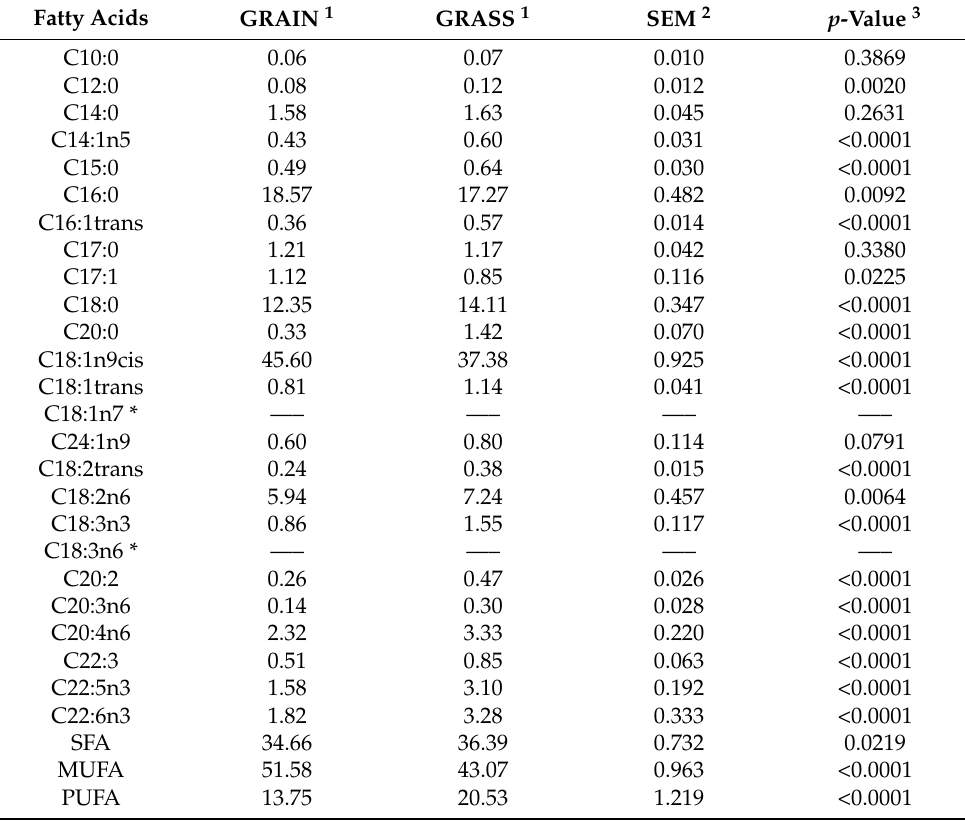
Table 5. Least square means for the effect of finishing system on the fatty acid composition (%, g/100 g total fatty acids) of raw tissue from bison longissimus dorsi of grain- or grass-finished bison heifers. Fatty Acids GRAIN 1 GRASS 1 SEM